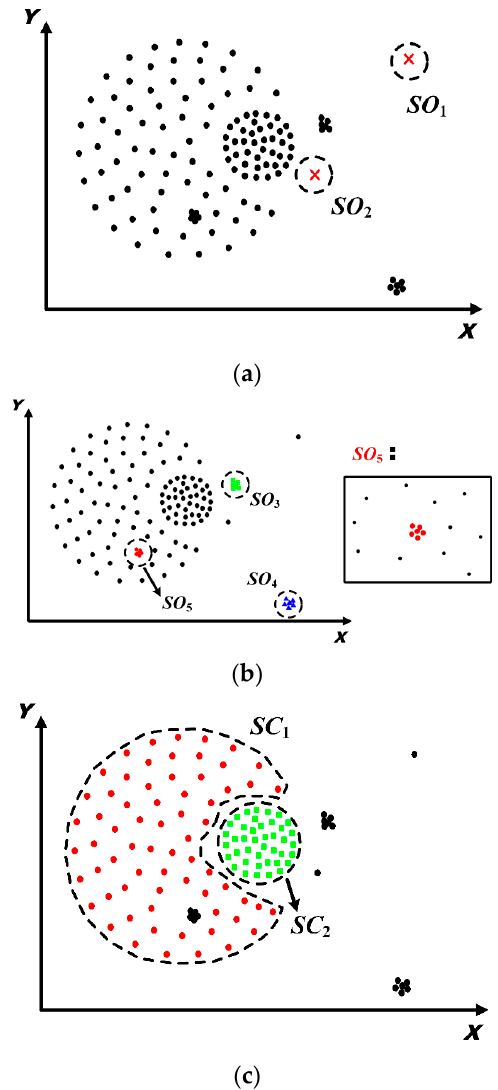
Figure 5. The process of identifying spatial clusters and spatial outliers. ( a ) spatial outlier points; ( b ) spatial outlier regions; ( c ) spatial outlier clusters.